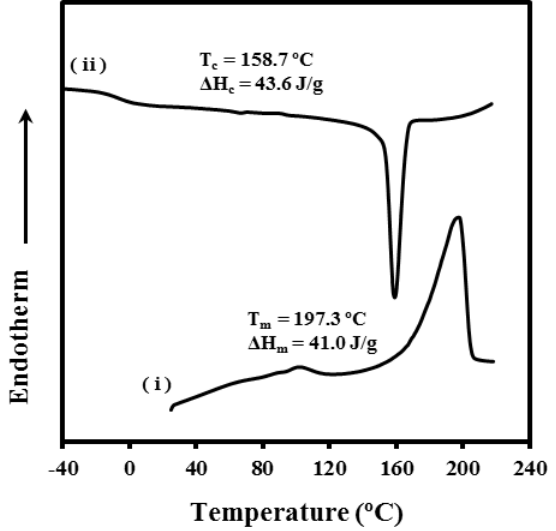
Figure 6. DSC traces obtained with the original γ irradiated GL- b -[GL- co -TMC- co -CL]- b -GL sample. Traces correspond to the first heating run (i) and the cooling run after keeping the sample in the melt state for 3 min